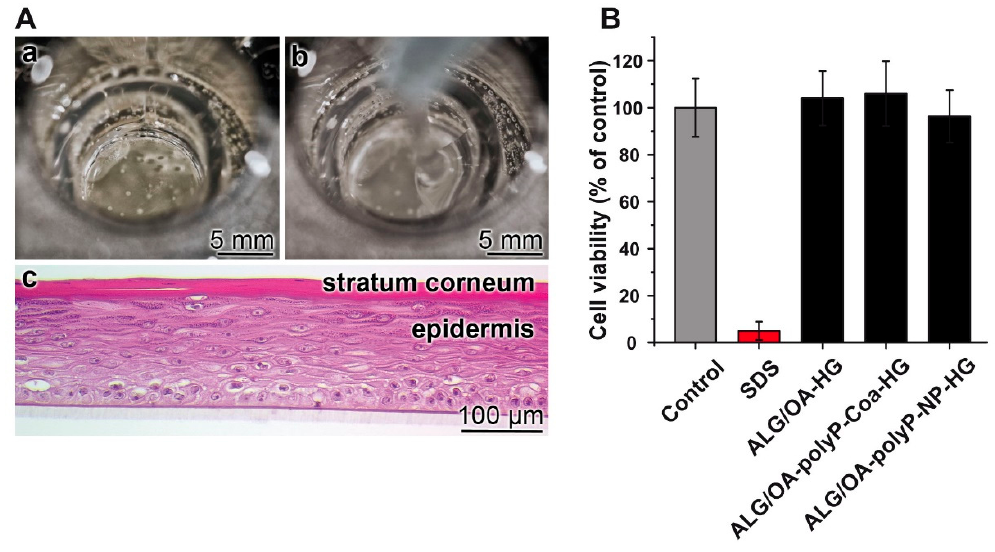
Figure 7. Determination of the viability of the hydrogels by using the in vitro reconstructed 3D human skin model. ( A ) the skin sample in the inserts of the well plates ( a ) prior and ( b ) after the addition of the hydrogel sample (200 µL). ( c ) Histological cross-section through the skin with the stratum corneum and the epidermis; staining with hematoxylin and eosin. ( B ) Short term skin irritation test by application of the MTT assay ( n = 5).